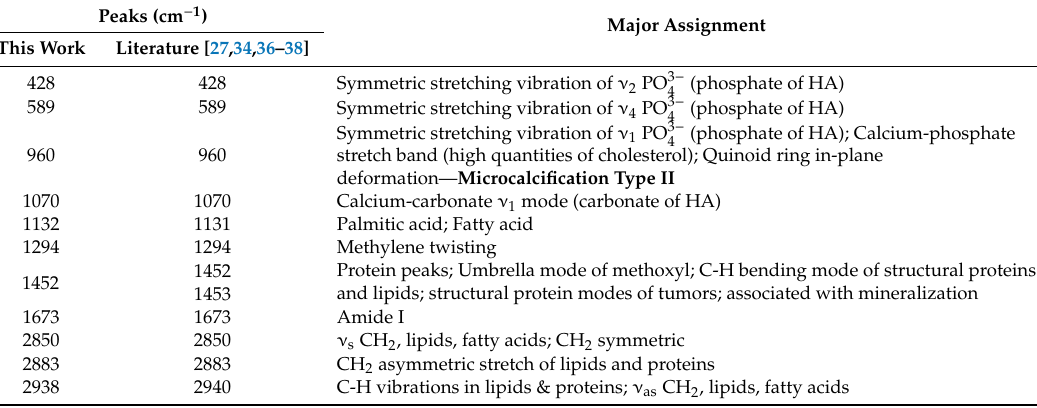
Table 4. Peak position and mode assignment of mineralized areas of benign mixed tumor (sample #1). Peaks (cm − 1